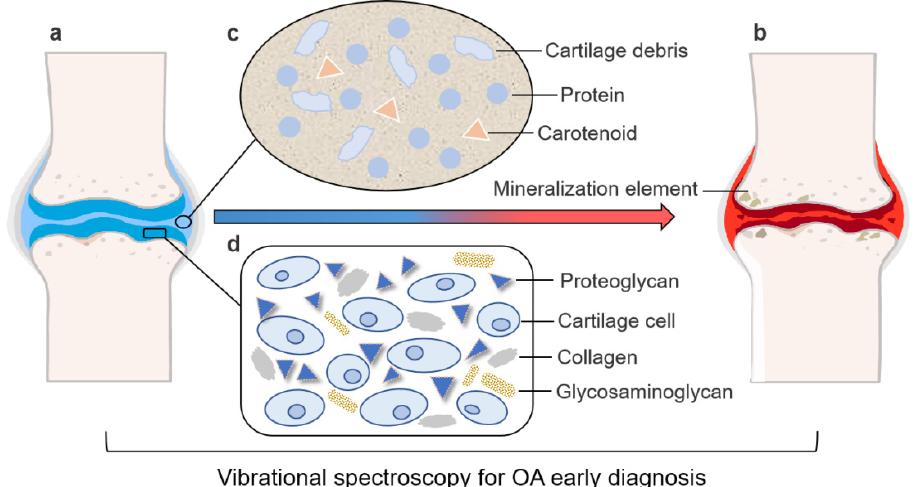
Figure 1. Vibrational spectroscopy is used for early OA diagnosis by detecting changes in the composition and morphology of articular cartilage and changes in synovial fluid (SF) and subchondral bone. The figure depicts ( a ) a healthy joint and ( b ) an OA-affected joint. In an OA-affected joint, the SF composition changes, articular cartilage becomes thinner and its composition changes, and the mineralization element in the subchondral bone increases. The main biomarkers of OA in ( c ) SF and ( d ) articular cartilage are also shown. Vibrational spectroscopy can detect the changes of these components for early OA diagnosis.